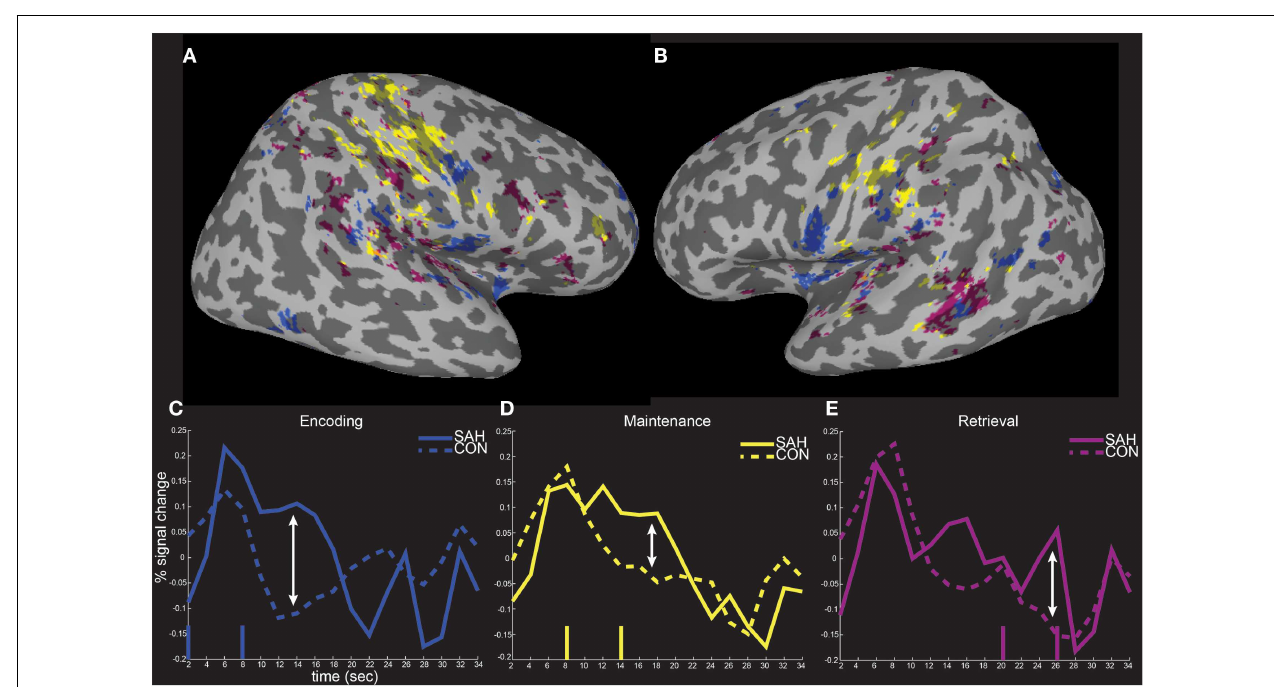
FIGURE 7 | Spatial localization of fMRI activity differences on inflated surface representations .The fMRI activity increases in patients from Figure 6 is shown on right (A) and left (B) hemisphere inflated surface representations of theTT_N27 brain. Average temporal responses within each of the significantly differently activated task periods are shown relative to the start and end (vertical lines) of the encoding (C) , maintenance (D) , and retrieval (E)